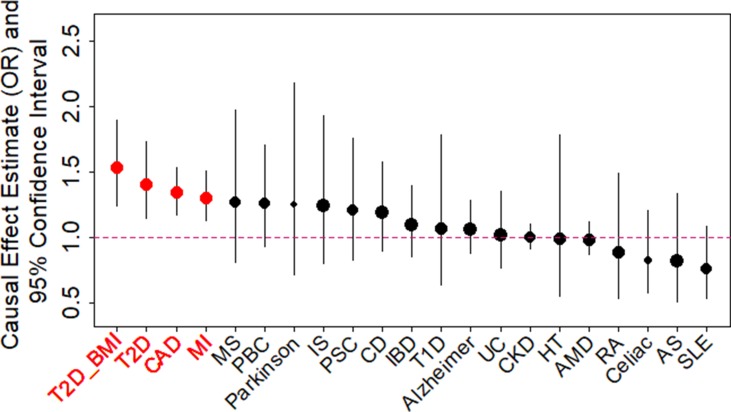
Causal effect estimates and 95% confidence intervals for lower birth weight on 21 diseases using the random-effects inverse variance weighted (IVW) method. Diseases are ordered based on their causal effect estimates. Estimations are carried out using both index SNPs and proxy SNPs. The dot size is proportional to the number of instrumental variables used for the given disease while dot color represents significance (p < 0.05 are highlighted in red). Disease names (x-axis) are further highlighted in red if the causal effects are significant after Bonferroni correction (p < 0.05/21).